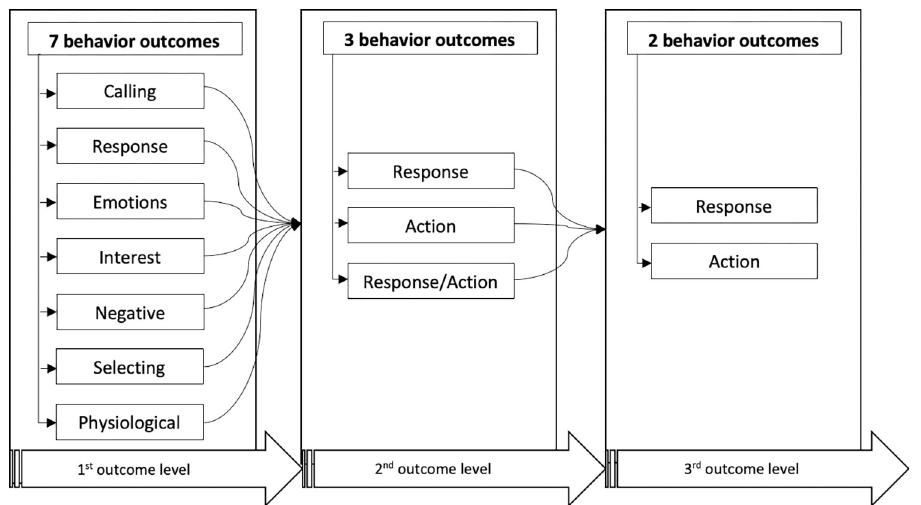
Fig 3. Behavior outcome classes in each outcome